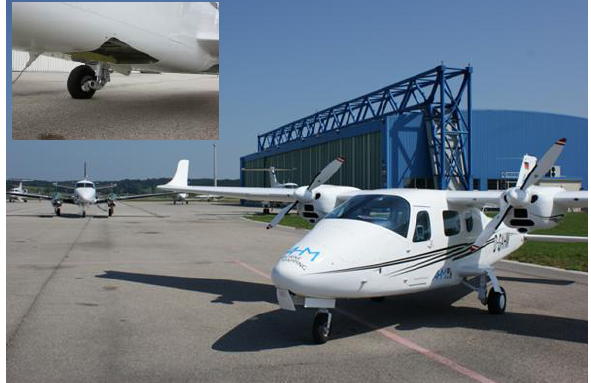
Figure 3: Special configured slow flight twin engine aircraft including three survey openings for hydromapping system and cameras (RGB,